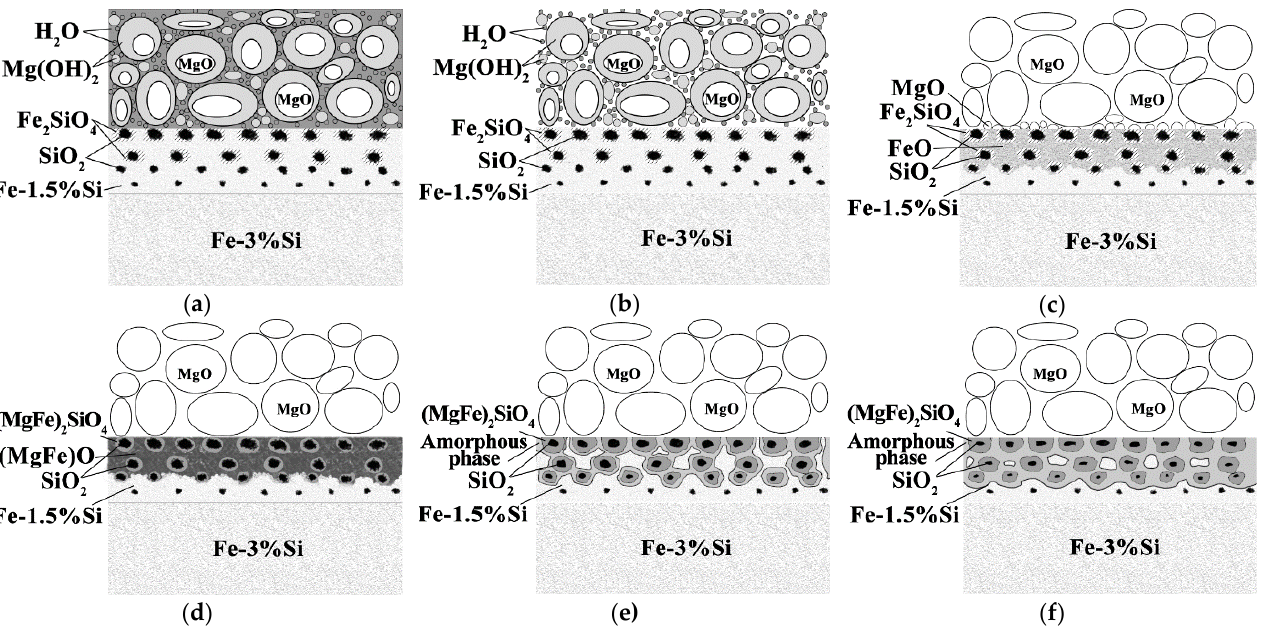
Figure 7. Possible glass film formation scheme on the Fe-3%Si-0.5%Cu alloy surface during HTA: ( a ) after applying the MgO suspension at about 10 °C; ( b ) after drying the MgO suspension at about ( a ) after applying the MgO suspension at about 10 ◦ C; ( b ) after drying the MgO suspension at about 150 °C; ( c ) heating at 300 – 700 °C; ( d ) heating at 700 – 900 °C; ( e ) heating at 900 – 1150 °C; ( f ) holding at 150 ◦ C; ( c ) heating at 300–700 ◦ C; ( d ) heating at 700–900 ◦ C; ( e ) heating at 900–1150 ◦ C; ( f ) holding 1150 °C. at 1150 ◦